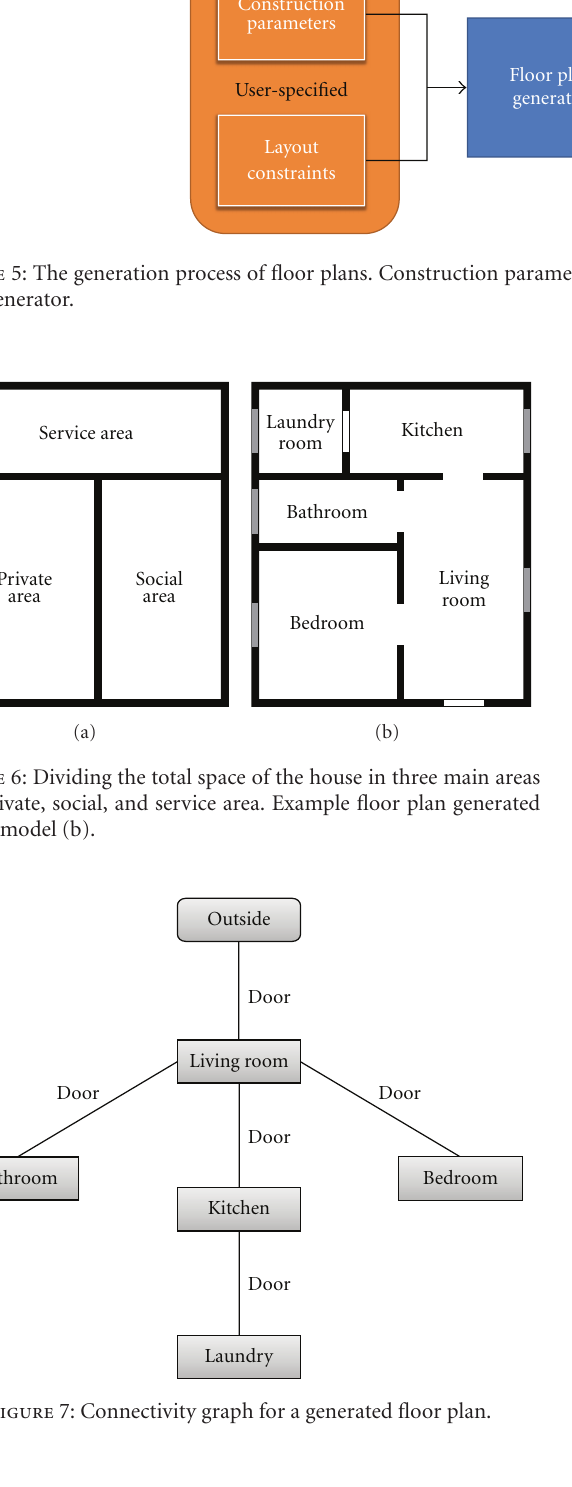
defined. A similar process happens with the generation of windows, but ensuring that they are placed on the external edges. Figure 6(b) illustrates a generated floor plan, contain- ing windows (dark rectangles) and doors (white